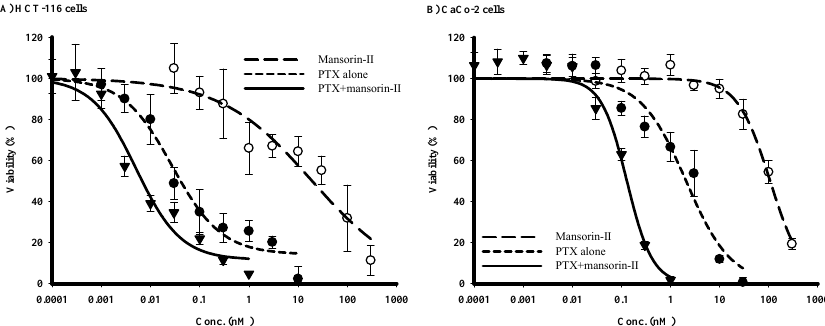
Figure 3. The effect of mansorin-II on the cytotoxicity of PTX in HCT-116 ( A ) and CaCo-2 ( B ) cell lines. Cells were exposed to serial dilution of PTX ( ● ), mansorin-II ( ○ ) or their combination ( ▼ ) for 72 h. Cell viability was determined using SRB assay.